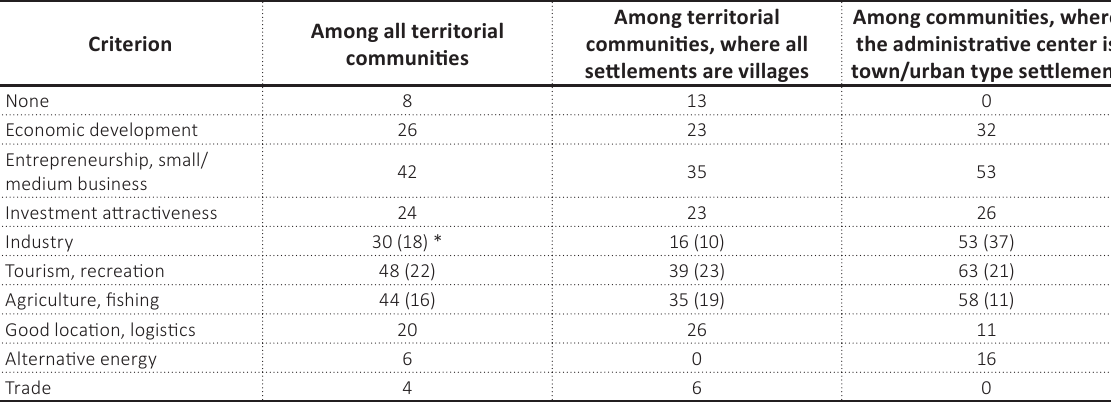
Table 3. Frequency of use of economic criteria positioning, %